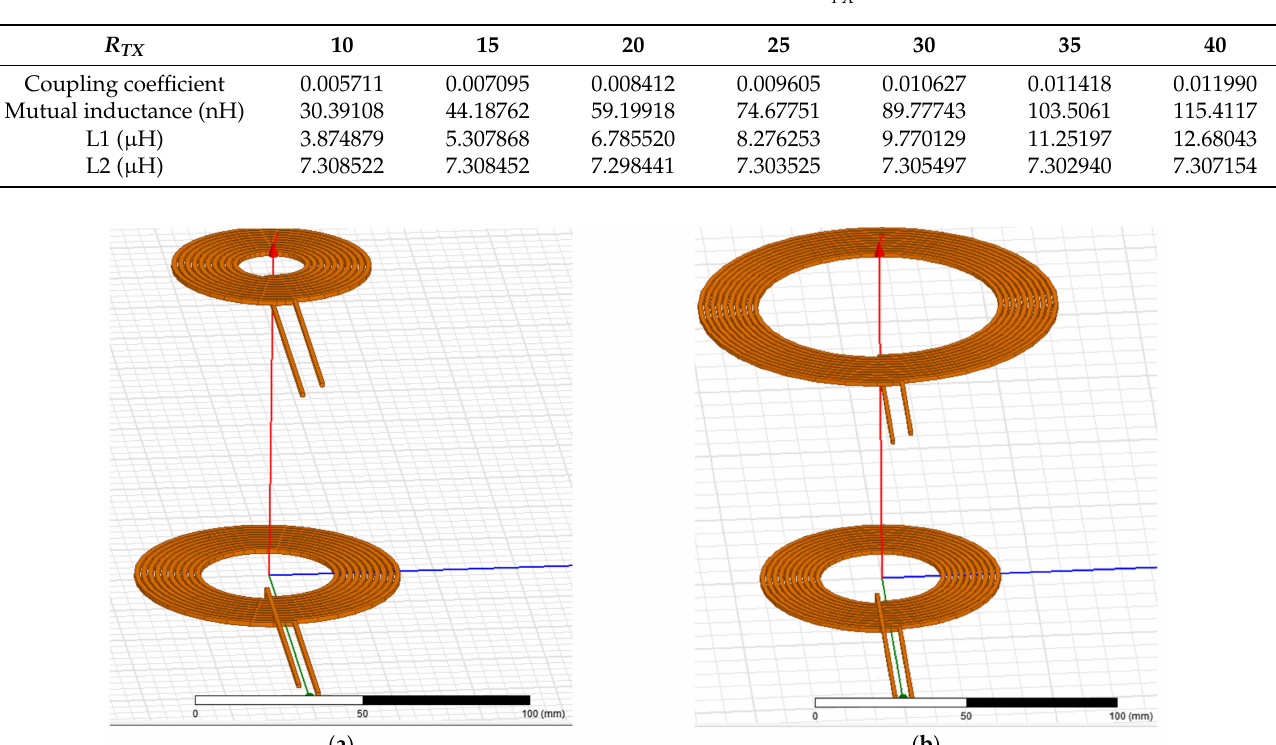
Table 7. Simulation results of circular coil model— R TX variation.